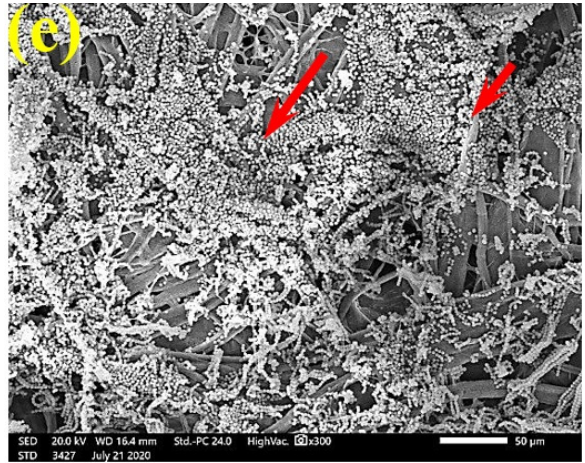
Figure 6. SEM images of paper sheets from ( a ) B. speclabilis , ( b ) F altissima , ( c ) F. elastica , ( d ) Z. mays, and ( e ) S. bicolor treated with 10% DMSO (control) and inoculated with A. fumigatus . Arrows refer to dense growth of fungal mycelia in sample fibers.